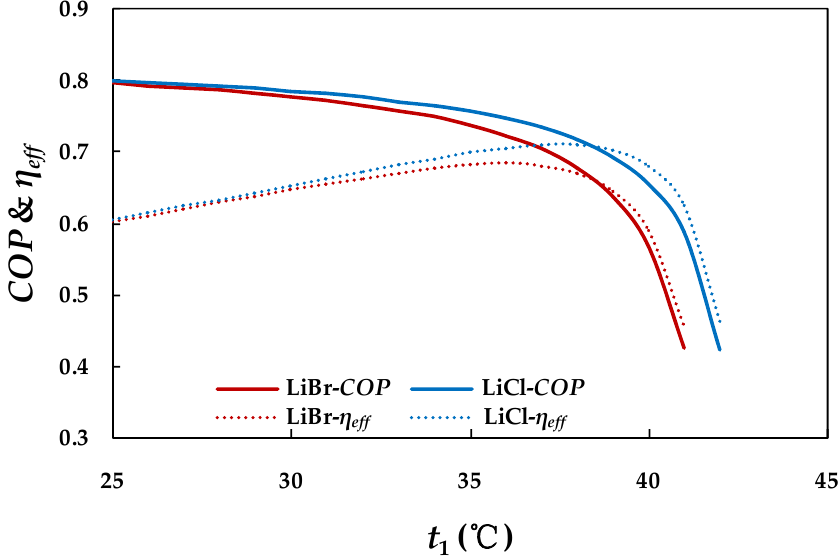
Figure 7. Absorber temperature impact on the COP and efficiency ratio of the absorption system under the examined operating condition for the two working pairs ( t 4 = 80 °C, t 8 = 40 °C, t 10 = 7 °C, ε = 0.7).